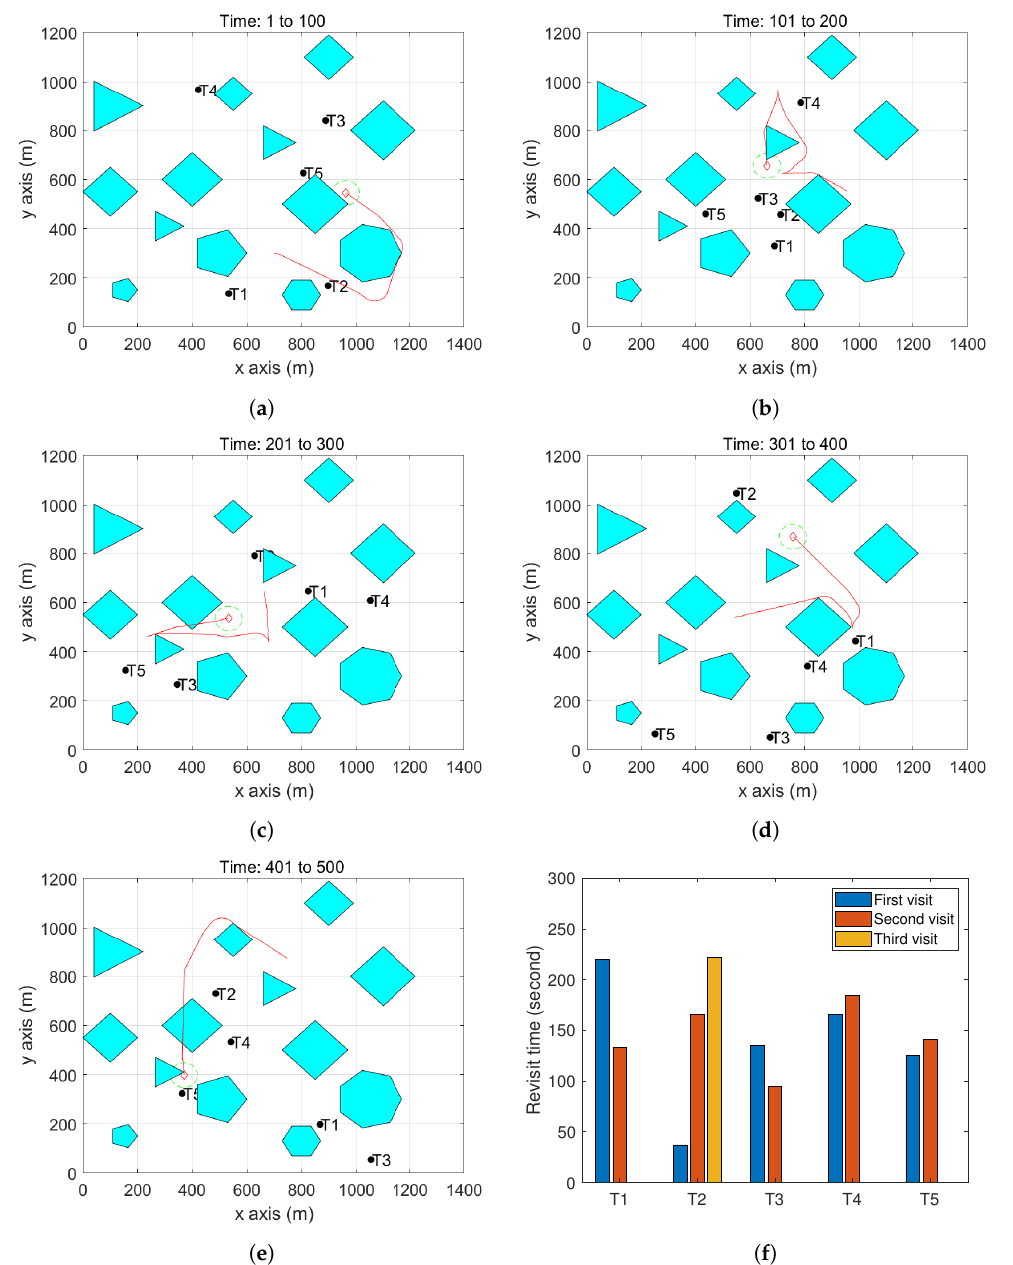
Figure 8. UAV trajectory when flying at 10 m/s. (2D view: https://youtu.be/7cx4jpr0W4I; 3D view: https://youtu.be/eXdSWdH1Yd8). ( a ) The UAV trajectory between 1 and 100 s. ( b ) The UAV trajectory between 101 and 200 s. ( c ) The UAV trajectory between 201 and 300 s. ( d ) The UAV trajectory between 301 and 400 s. ( e ) The UAV trajectory between 401 and 500 s. ( f ) The revisit time of each target during the